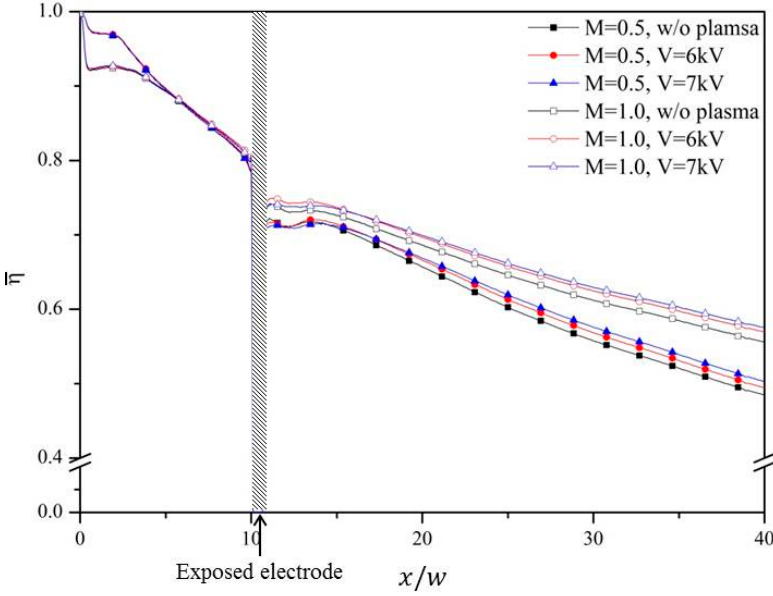
Figure 9. Laterally-averaged film cooling effectiveness ( (cid:1838) (cid:2915) = 10 w).